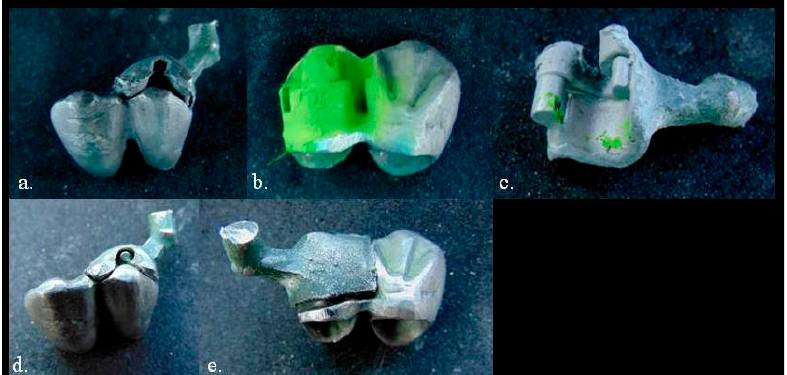
Figure 13. ( a ). Insertion of the Pb- framework on the surface of the Pa framework after uncoating; ( b ). The surface of the Pa framework sprayed with adaptation marker; ( c ). Printing the marker on the friction areas with the assembly surface of the complementary framework Pb-; ( d ). Vertical advancement of the joint between parts Pa and Pb-; ( e ). The distance between the parts during the adjustment process.